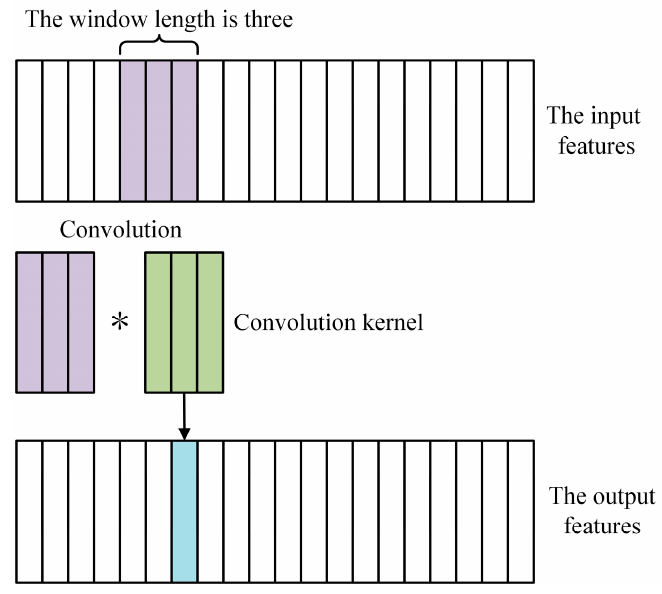
Figure 3. Schematic diagram of 1D-CNN. The structure of the 1D-CNN network consists of the convolution layer, pooling layer, and full connection layer. The operation of the convolution layer is equivalent to the process of pretreatment and feature extraction in traditional machine learning [22]. Before convolution, the size of the convolution kernel and the number of filters need to be set and these two parameters are obtained through multiple experiments. The maximum pooling was selected as the pooling layer, which can reduce the dimension of feature mapping without losing important information, thus cutting computation amount and time of network training. The fully connected layer acted as the classifier in CNN and optimizes the network as the feature combination layer. In order to prevent over-fitting in training data, a dropout layer was added to the network structure to suppress over-fitting by removing some neurons. The flow chart of the network framework of the 1D-CNN model is shown in Figure 4. based on Python